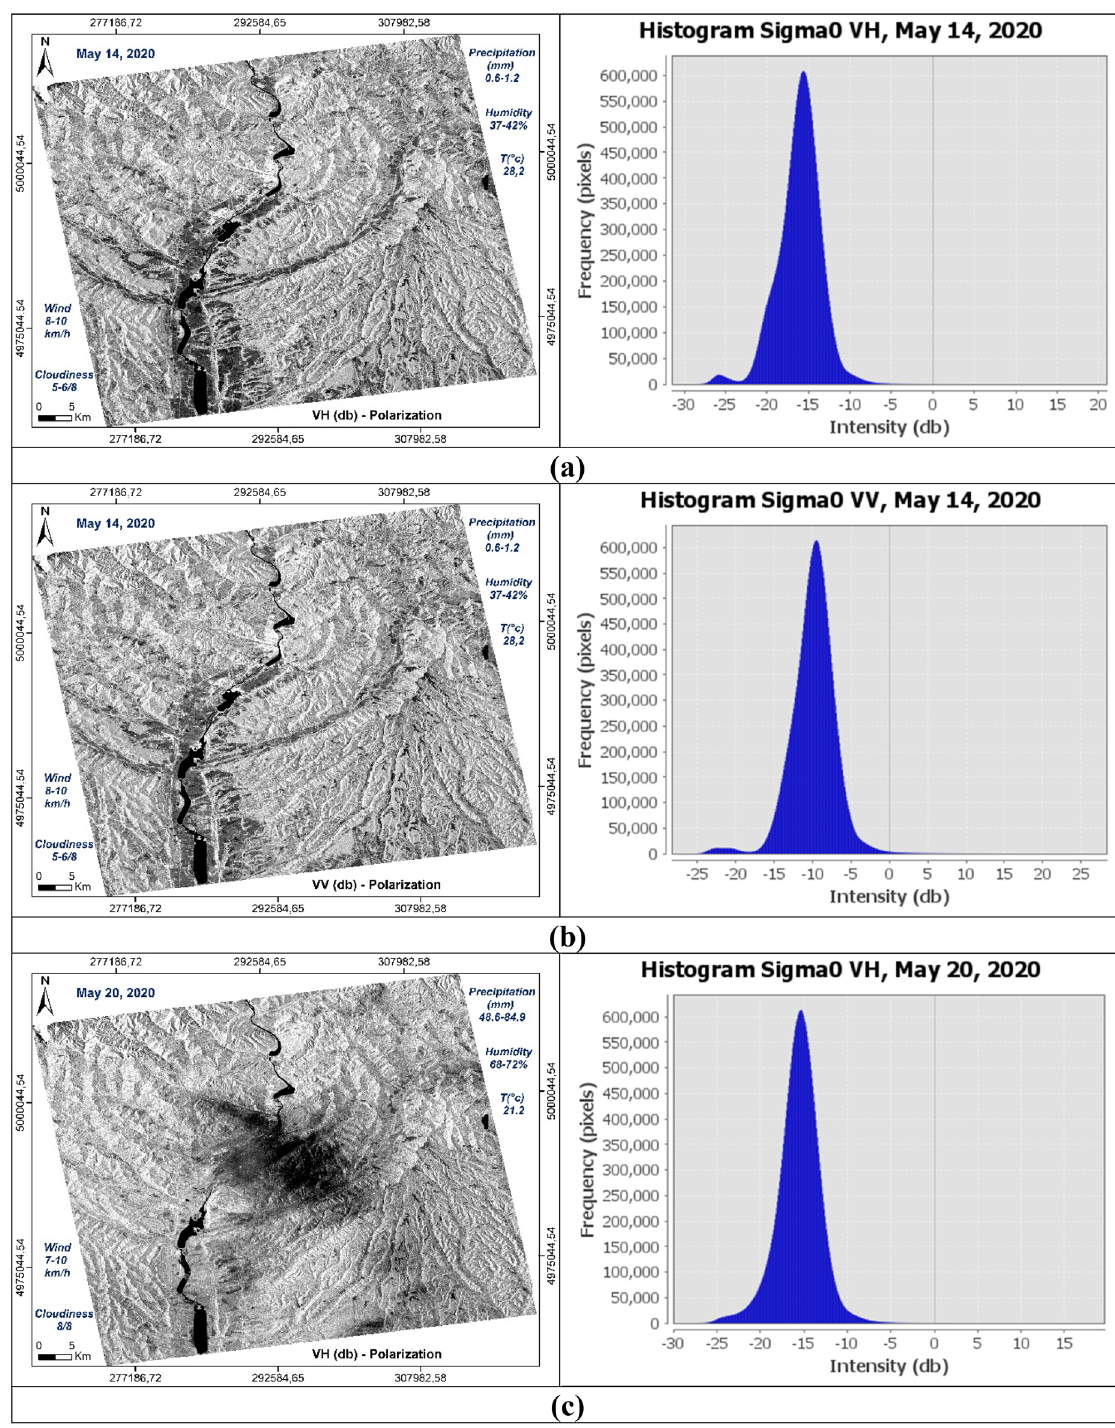
Figure 10. Histograms of the two polarisations VV and VH of the three SAR images used, dated before (14/05/2020), during (20/05/2020) and after (01/06/2020) the